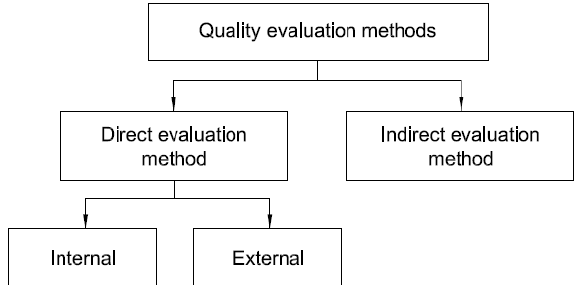
Figure 4: Classification of data quality evaluation methods (ISO